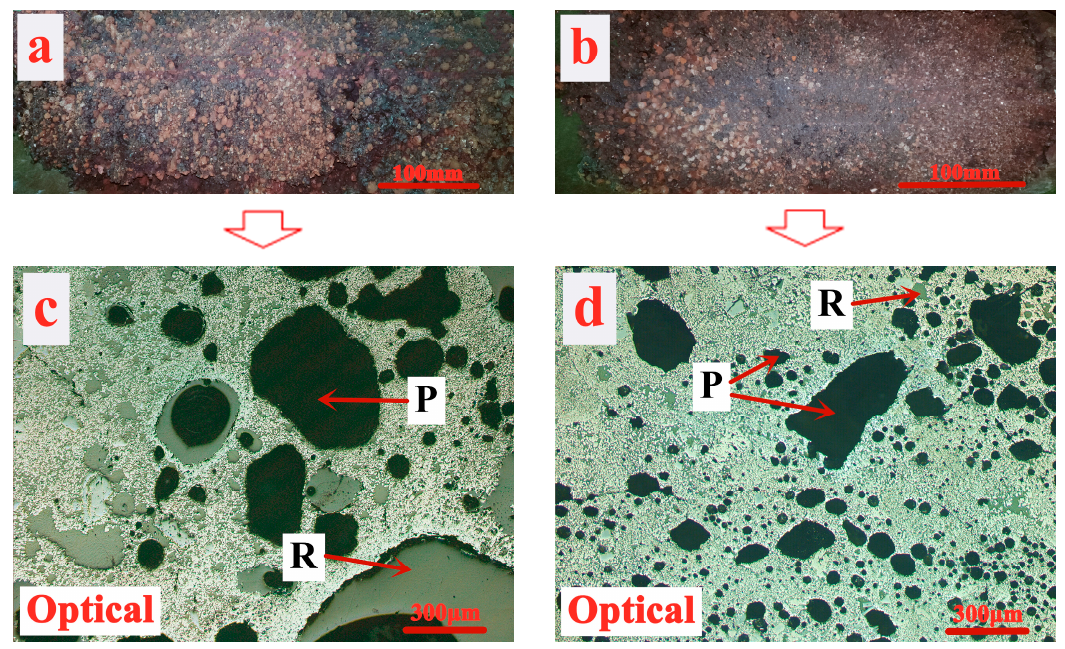
Figure 6. Porous structure of product sinter of different sintering processes (P—Pore, R—Resin), ( a ) and ( b ) are porous macrostructures of the sinter of the traditional and pressurized densification sintering processes, respectively; ( c ) and ( d ) are porous microstructures of the product sinter of the traditional and pressurized densification sintering processes, respectively.